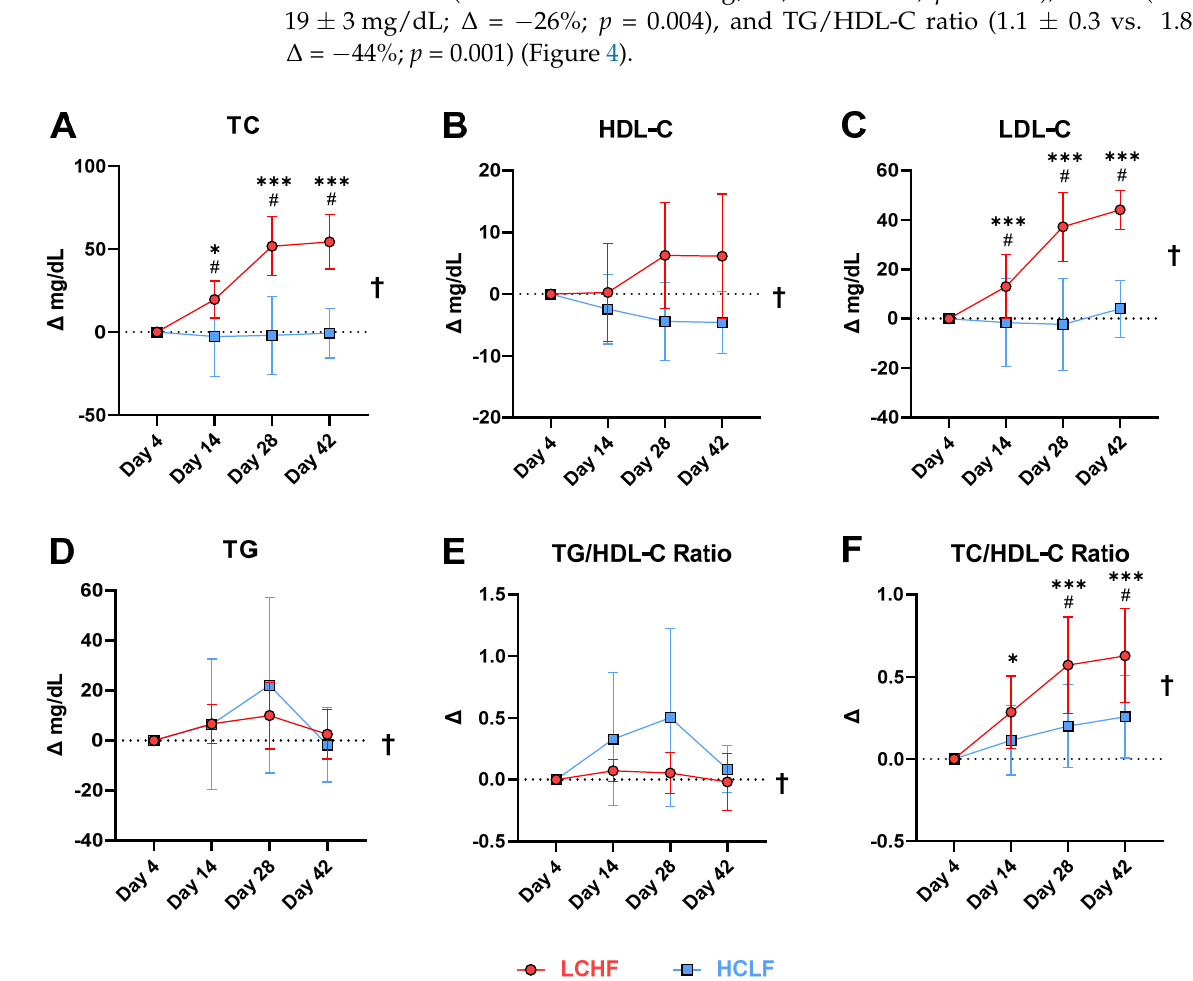
Figure 4. Baseline normalized change in plasma lipid markers. ( A ) total cholesterol, ( B ) HDL-C cholesterol, ( C ) LDL-C cholesterol, ( D ) triglycerides, ( E ) triglyceride to HDL-C ratio, and ( F ) total cholesterol to HDL-C cholesterol ratio. ANOVA revealed a main effect of diet in all the markers analyzed († = p < 0.05). Overall, LCHF diet lowered circulating triglycerides and TG/HDL-C ratio while simultaneously increasing HDL-C when compared to the HCLF diet. A significant interaction was detected for total cholesterol, LDL-C, and TC/HDL-C ratio. Compared to HCLF, the LCHF diet elicited significantly higher cholesterol and LDL-C values, and greater TC/HDL-C ratios at day 14 and thereafter. Main effects: Time: *, *** p < 0.05/0.001 compared to Day 4; Condition e ff ects: † = p < 0.05; Interaction: # = p < 0.05 between conditions at indicated timepoints. Data presented as mean ± SD; n = 7.